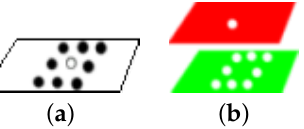
Figure 8. ( a ) Pixel gray LBP code: the code for the central pixel (i.e., white small disk) is computed with respect to his neighbors (i.e., 8 black small disks). ( b ) Pixel opponent color LBP code for RG pair: the central pixel is in the first color channel (red) and the neighbous are picked in the second channel